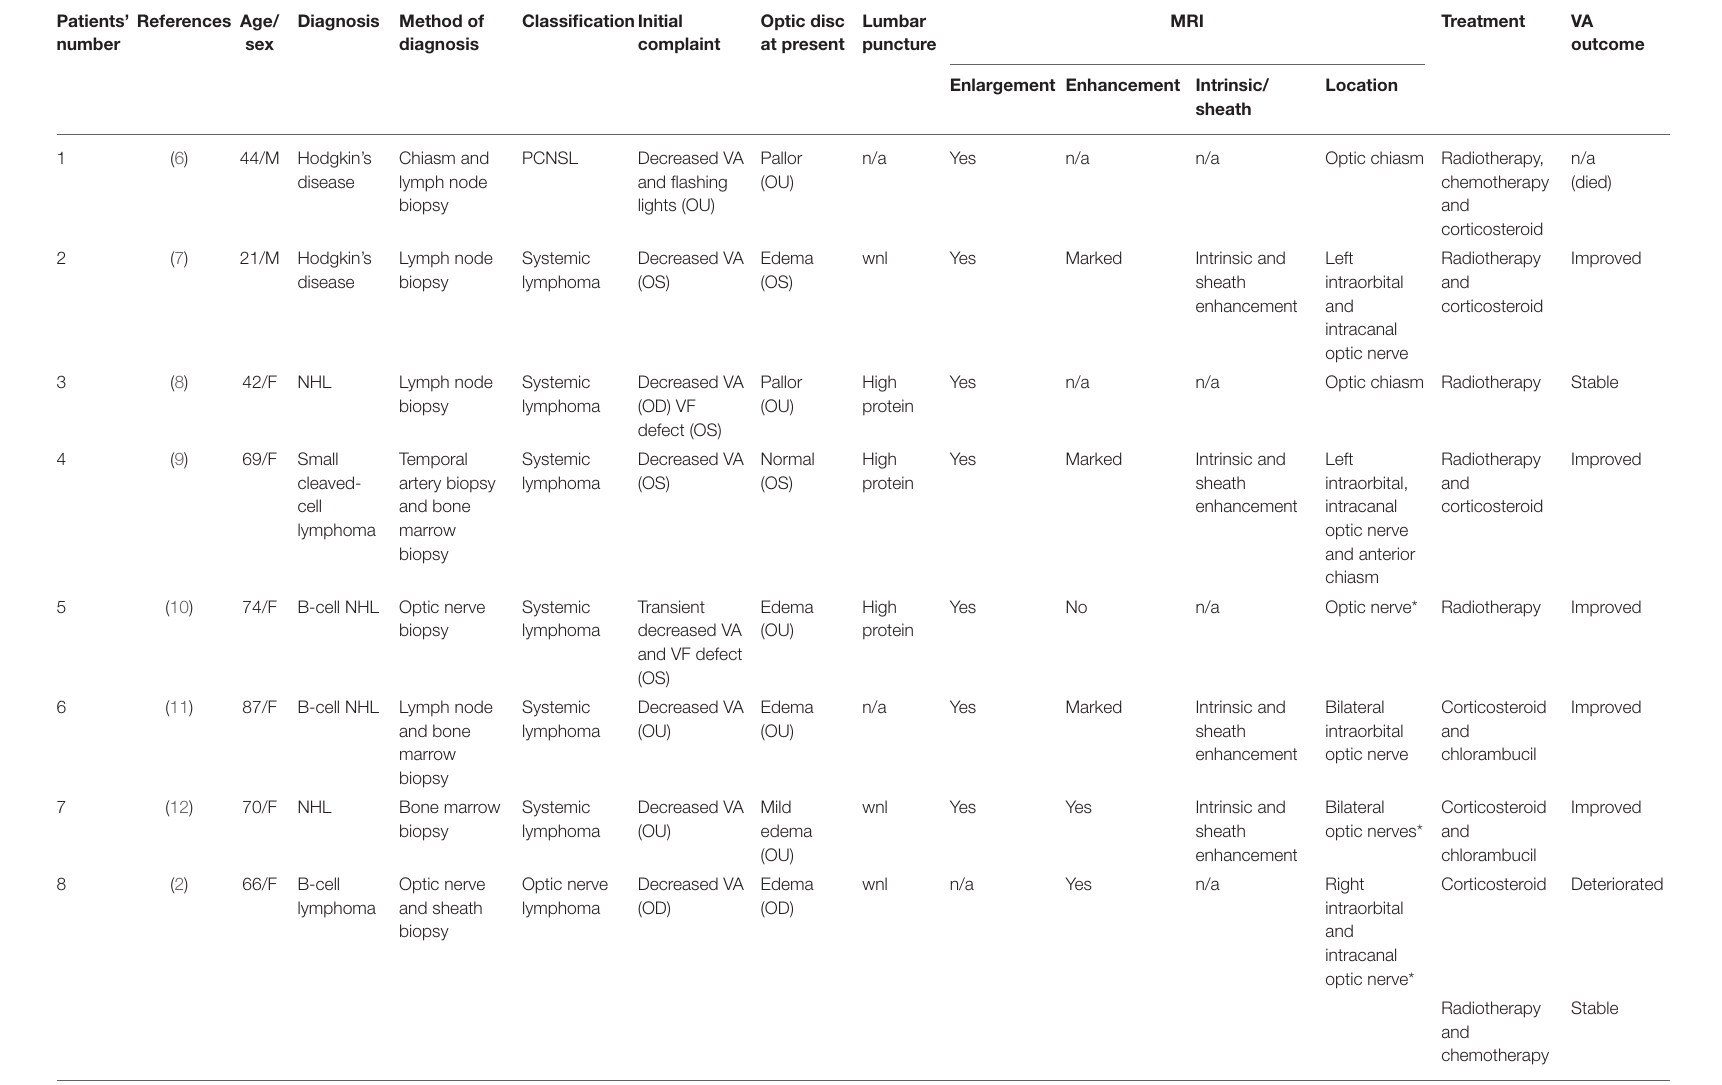
TABLE 1 | Cases of optic nerve lymphoma. Patients’ References Age/ Diagnosis Method of number sex